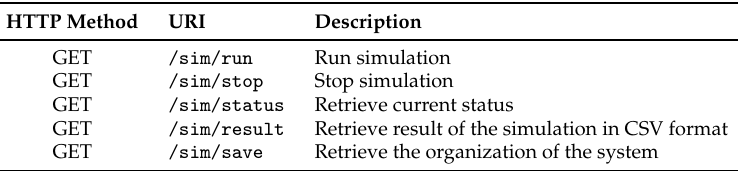
Table 3. Agent Manager API in simulator mode.